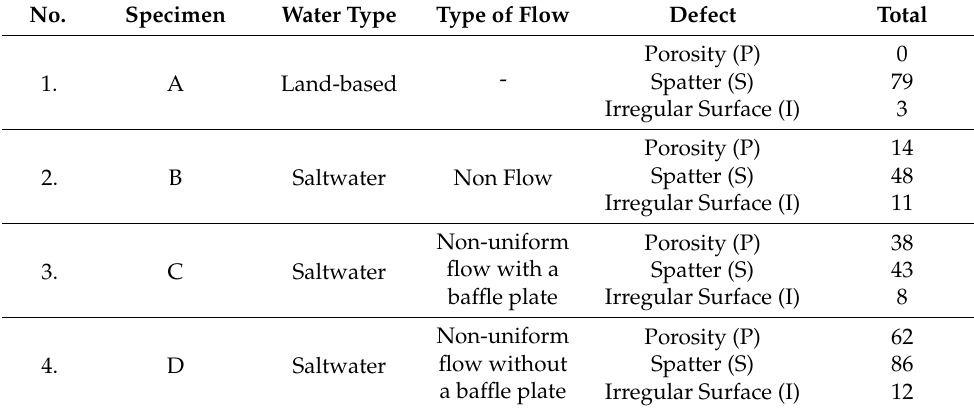
Table 4. Data observations of visual defects in specimens.